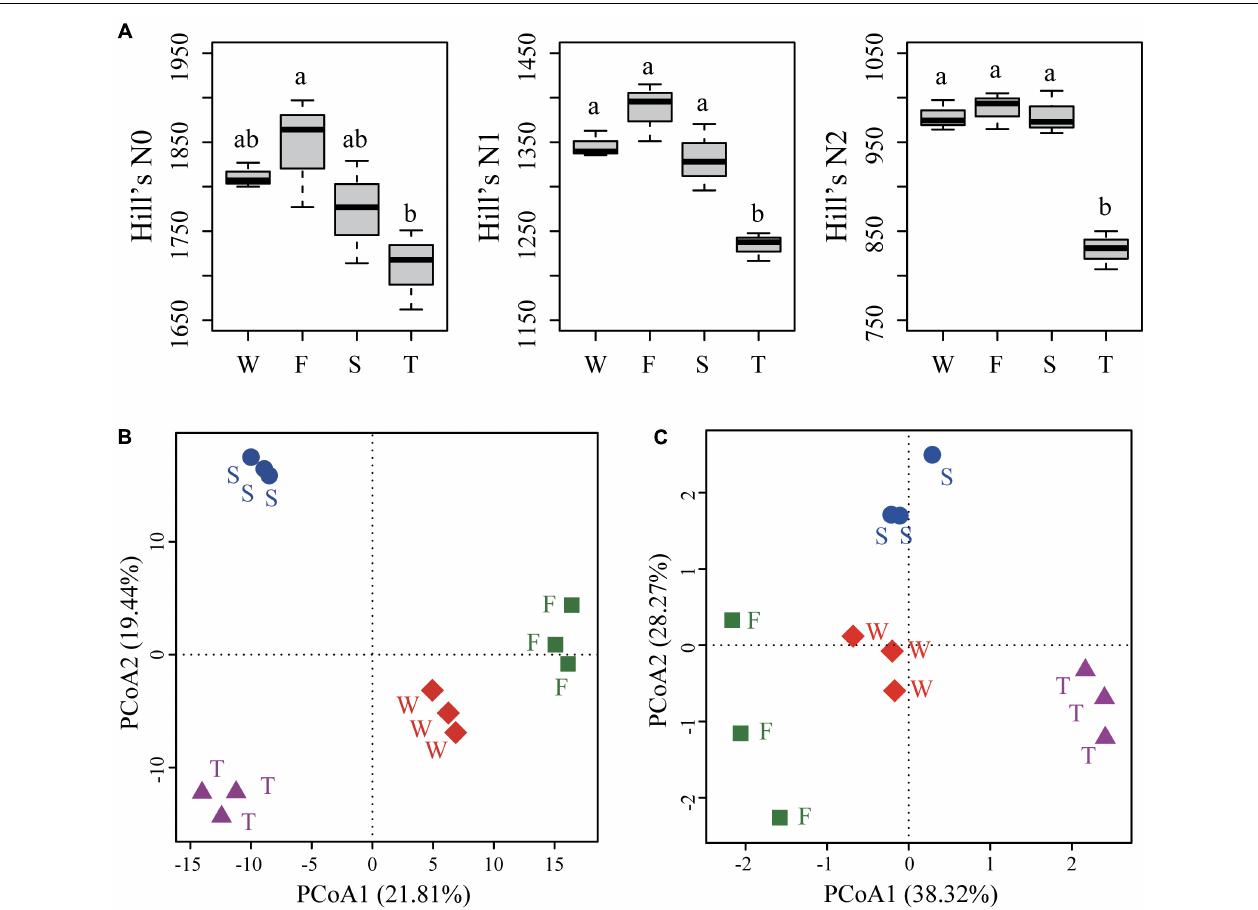
FIGURE 3 | Alpha diversities (A) and PCoA analyses of soil bacterial community structure (B) and function profile (C) . (A) Hill’s series of diversity was calculated from unrarefied data. Different letters indicate significant difference based on Tukey’s HSD test ( P < 0.05). (B) The PCoA analysis of soil bacterial community structure was based on the Euclidean distance of the centered log-ratio (CLR) transformed read counts at the OTU level. (C) The PCoA analysis of soil bacterial community function profile was based on the Euclidean distance of the CLR transformed pathway numbers at KEGG level 3. OTUs were delineated at 97% sequence similarity. W represents the wheat field; F, S, and T represent the first, second, and third cropping of Jerusalem artichoke (JA),